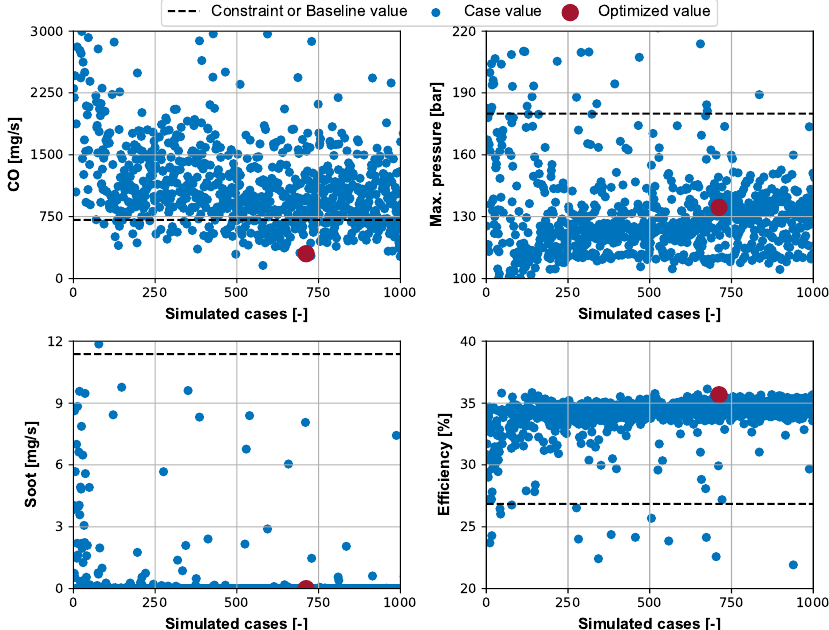
Figure 8. Evolution of constraints and objectives outputs toward the optimized value. The dependency of the objective function value on the geometrical parameters is shown in Figure 9, where again the red dot represents the optimized case and the blue dots are the value of each parameter for each case. The geometrical parameter 1 (GP1) adjusts the depth of the piston and is presented in the left-top graph. The optimization process tends to move the value of GP1 toward regions near the maximum limit of this parameter, decreasing the height of the piston bowl. For the geometrical parameter 2, most points are concentrated near to the maximum limit of this parameter, suggesting that the bowl diameter increment would enhance the performance of the oxy-fuel combustion concept. The evolution of the geometrical parameter 3 during the optimization process starts with some cases in the minimum limit moving to an intermediate region of the total range, but nearer to the maximum limit. This evolution modifies the point GP3 in Figure 4, changing the initial geometry of the deep re-entrant piston toward an almost no re-entrant geometry. The geometrical parameters 4 and 5 are responsible for adjusting the curvature between the points GP2 and GP3 (shown in Figure 4) and the alignment between GP1 and GP2, respectively. The GP4 has values in the middle of the parameter range in order to obtain a smoother bowl shape with a lower objective function. Then, the GP5 was conduced to the maximum value of the range, again avoiding the re-entrant shape. The last parameter, the GP6, is capable of updating the bowl centre depth. The results for this parameter converge close to the maximum value